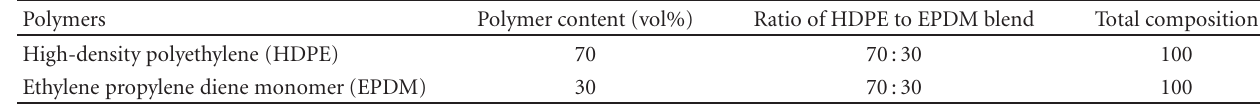
Table 1: Preparation of HDPE/EPDM blend (polymer matrix) via melt blending method.